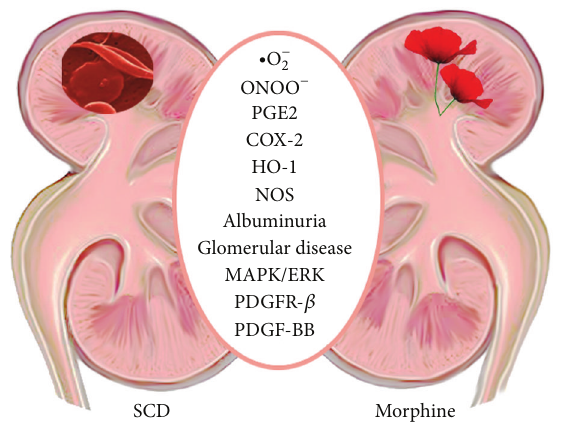
Figure 2: Proposed model of morphine activity in the kidney. Mor- phine stimulates cyclooxygenase-2 (COX-2), hemoxygenase-1 (HO- 1), inducible/endothelial nitric oxide synthase (i/e NOS), oxidative stress via reactive oxygen species/peroxynitrite, mitogen activated protein kinase/extracellular signal regulated kinase (MAPK/ERK), platelet-derived growth factor receptor- 𝛽 (PDGFR- 𝛽 ), and platelet- derived growth factor-BB (PDGF-BB). These molecular changes are accompanied by albuminuria and glomerular pathology in morphine treated mice. Together, these morphine-induced cellular, molecular, and pathological effects may stimulate and exacerbate existent renal damage in sickle cell